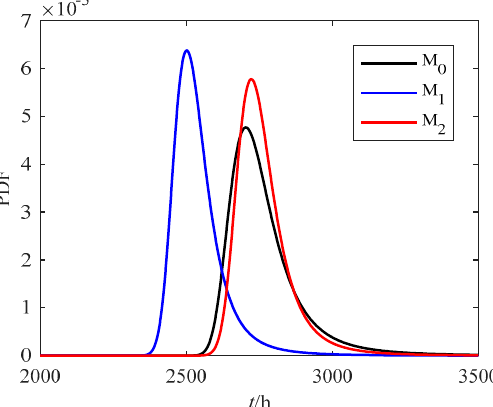
Figure 4. Comparison of PDF of lifetime at 85 °C for accelerometers.